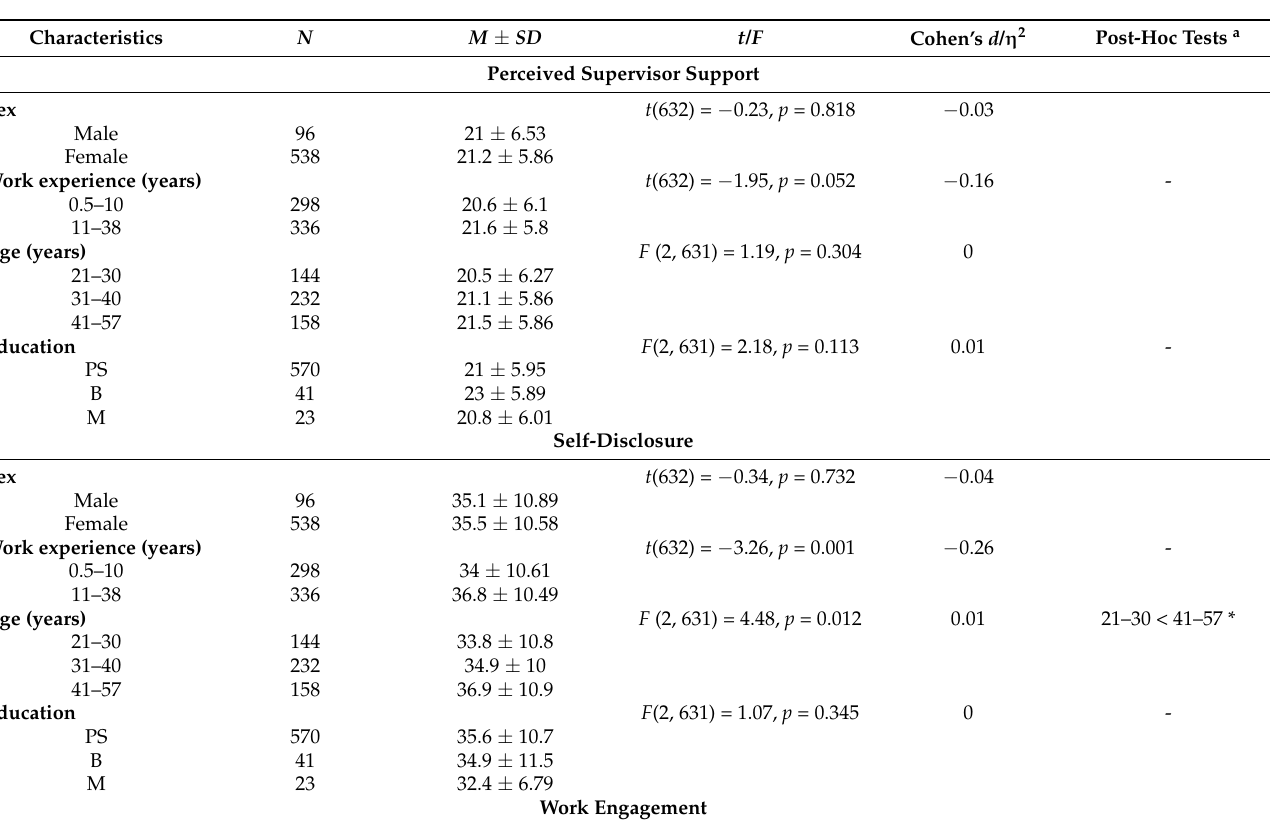
Table A2. Socio-demographic differences in perceived supervisor support, self-disclosure, work engagement, emotional exhaustion, depersonalization, personal accomplishment, burnout, and turnover